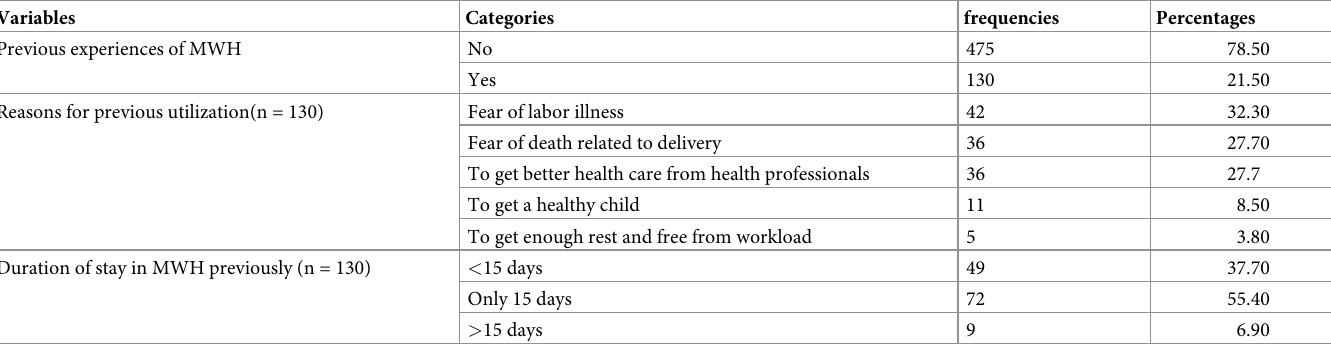
Table 3. Past experiences in MWH service utilization among pregnant women.